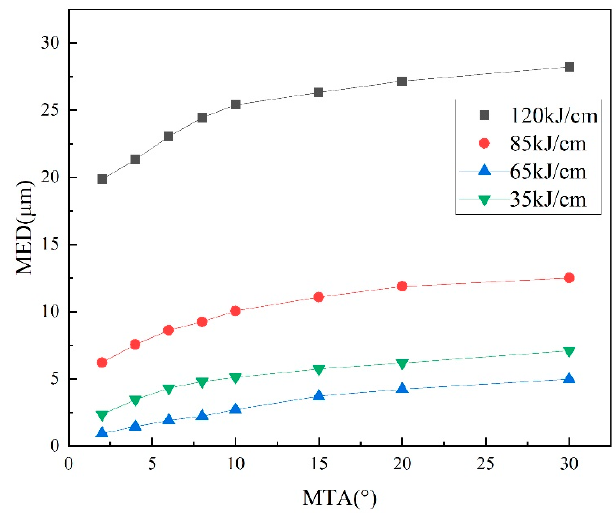
Figure 10. EBSD MED as functions of MTA and the heat input.